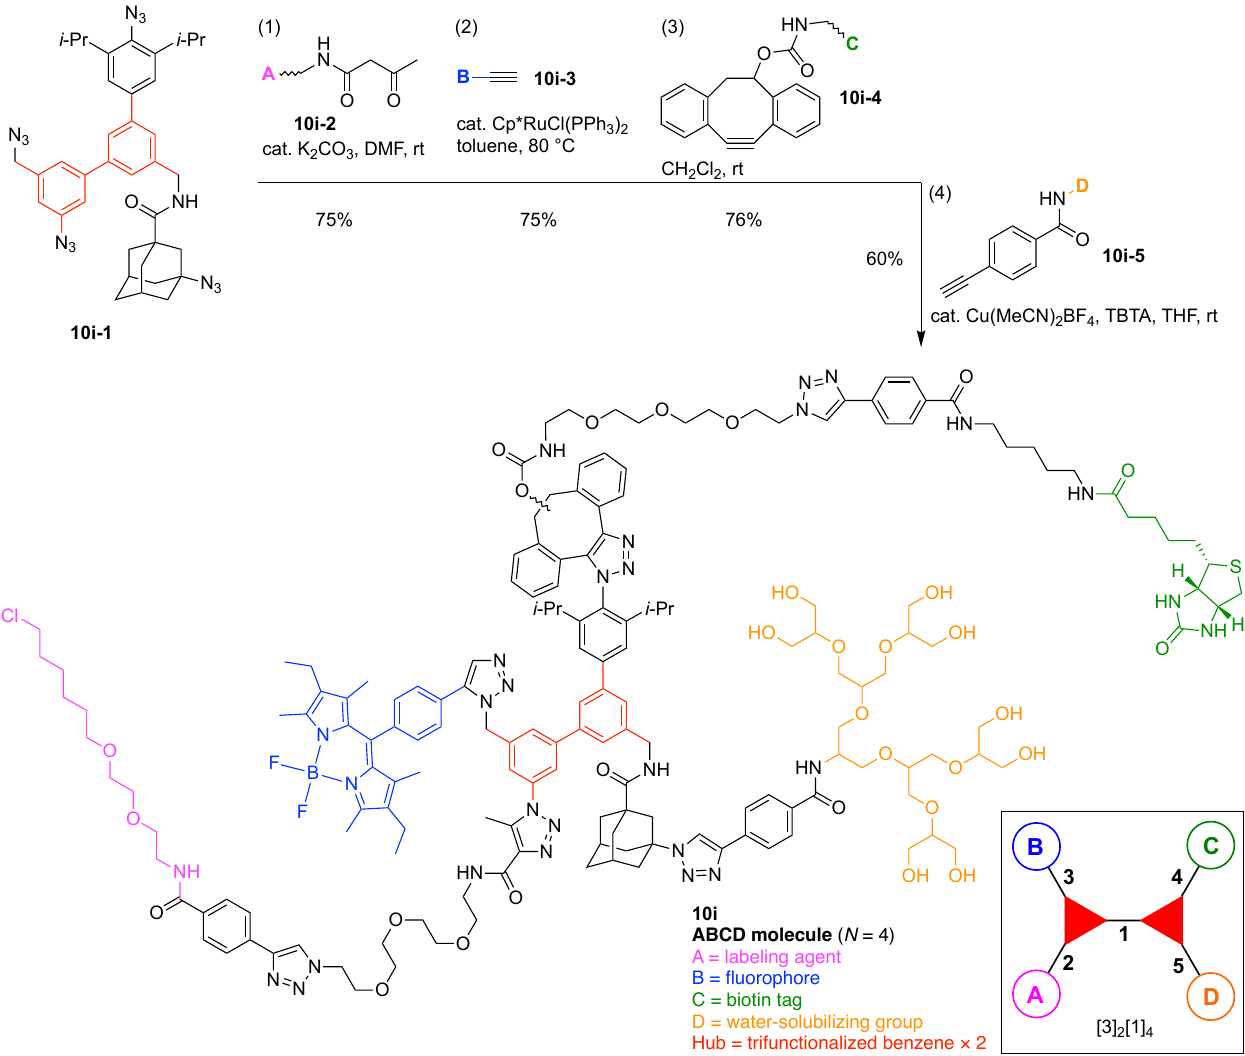
Figure 48. A tetrafunctionalized scaffold built around two benzenes and elaborated by consecutive formation of 1,2,3-triazoles.